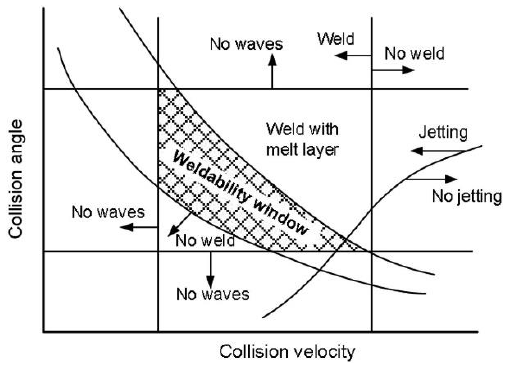
Figure 6. Generic welding window (reproduced from [10], with permission of Elsevier 2019).